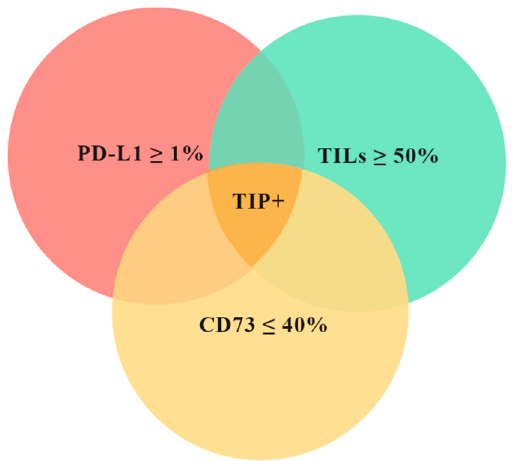
Figure 2. Graphic representation of tissue immune profile (TIP). Figure 2 shows the conceptual Venn diagram of TIP + patients. The red circle represents patients with PD-L1 ≥ 1%, the green circle patients with TILs ≥ 50% and the yellow circle patients with CD73 ≤ 40%. TIP + patients are identified by the dark yellow area. TIP + : tissue immune profile positive; TILs: tumor infiltrating lymphocytes.